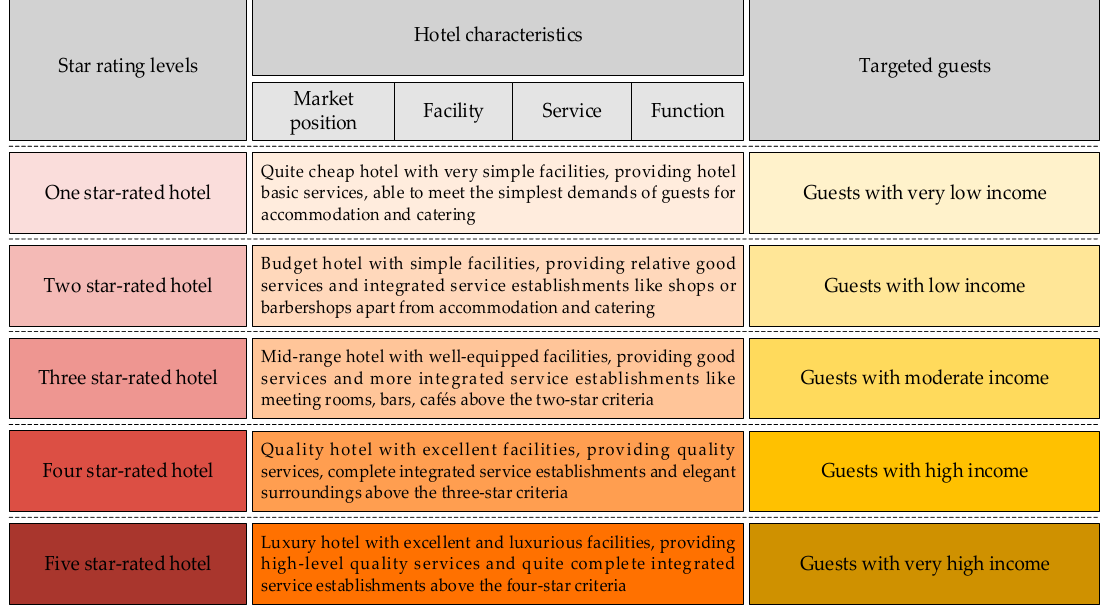
Figure 2. Criteria for classifying hotels with different stars.